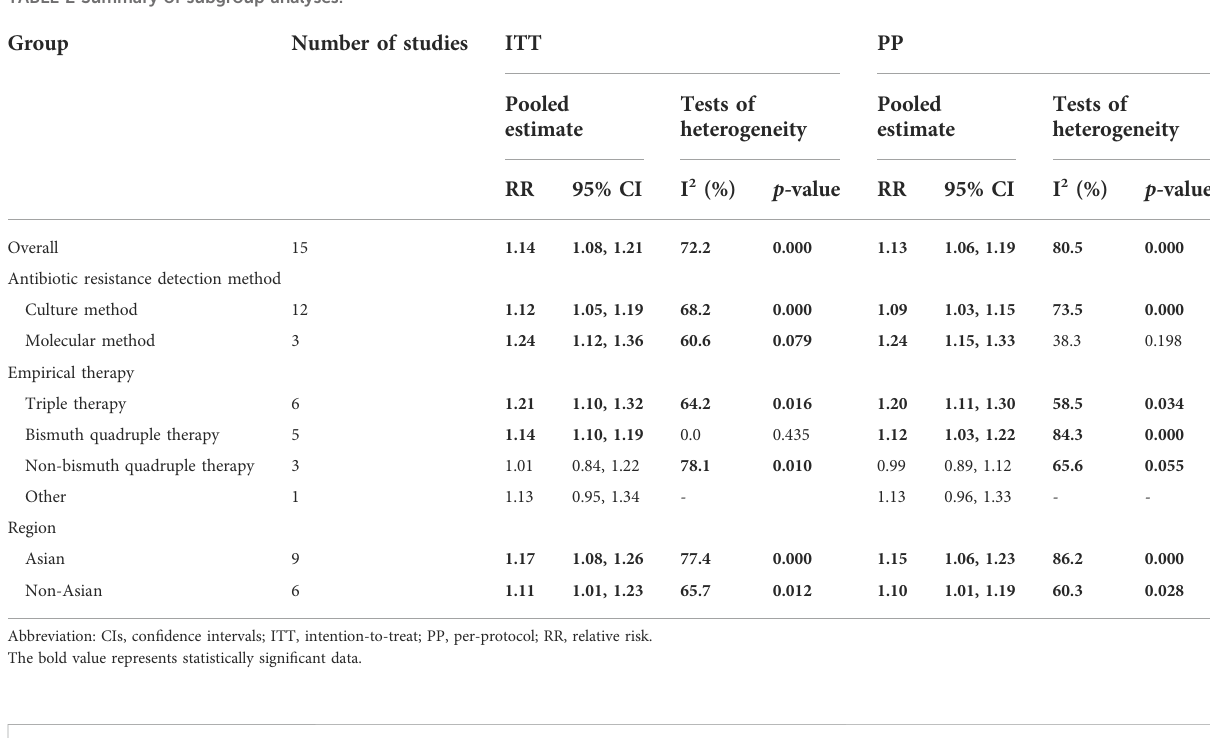
TABLE 2 Summary of subgroup analyses.